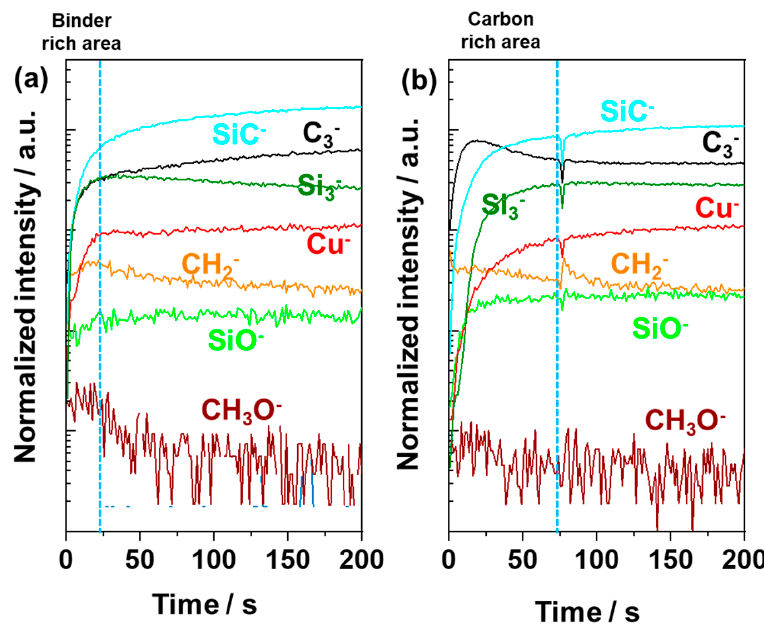
Figure 6. ToF-SIMS negative ion depth profiles for pristine ( a ) Si-XG-AB electrode; ( b ) Si@C-network Figure 6. ToF − SIMS negative ion depth profiles for pristine ( a ) Si − XG − AB electrode; ( b ) Si@C − net- electrode (sputtering area 300 µ m × 300 µ work electrode (sputtering area 300 μ m × 300 μ m).